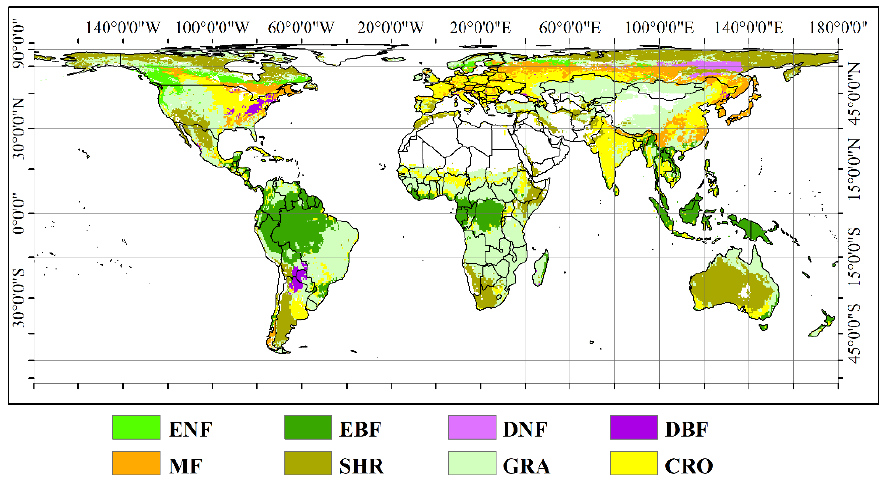
Figure 1. The spatial pattern of the global land cover map.